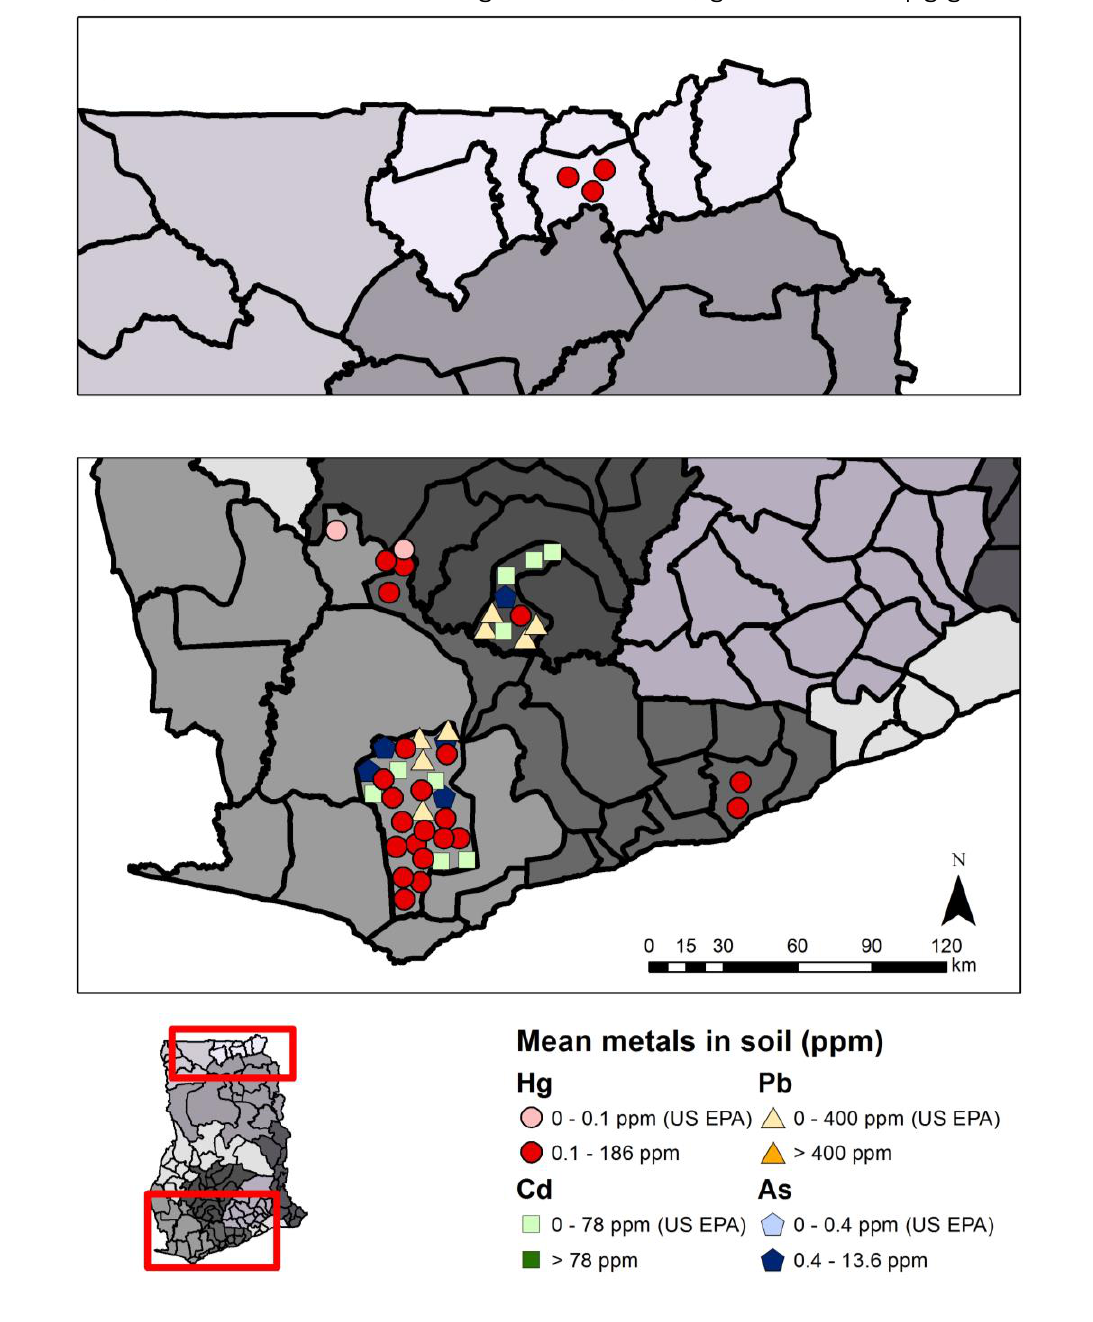
Figure 5. Metals in soil samples in southwest (bottom panel) and northeast (upper panel) Ghana. Each symbol represents the mean metals value (µg/g, ppm) from a single study in that region, and for illustrative convenience the symbols are scattered randomly within the district where the sampling took place. Political regions are distinguished by different shades of grey. Mean total mercury (Hg), lead (Pb), cadmium (Cd), or arsenic (As) above or below guidelines are